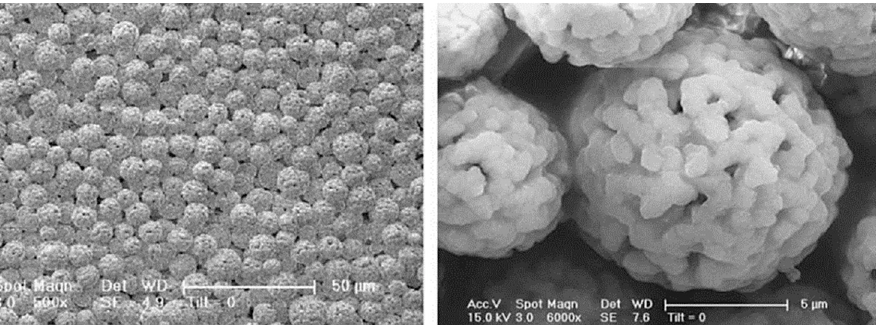
Figure 24. SEM photomicrographs for the SiO 2 microspheres prepared by the W/O emulsion method combined with sol-gel transition and phase separation, using TEOS as Si precursor and PEO as phase separation inducer additive. Their narrow size distribution is due to liquid elutriation techniques, which allowed to select microspheres of diameter ranging from 6 to 10 µm. Scale bar = 50 µm (left); 5 µm (right). Reprinted from Microporous Mesoporous Mater., Vol. 116, Z. G. Shi, Y.Q. Feng, Synthesis and characterization of hierarchically porous silica microspheres with penetrable macropores and tunable mesopores, Pages 701–704, Copyright (2008), with permission from Elsevier [112].